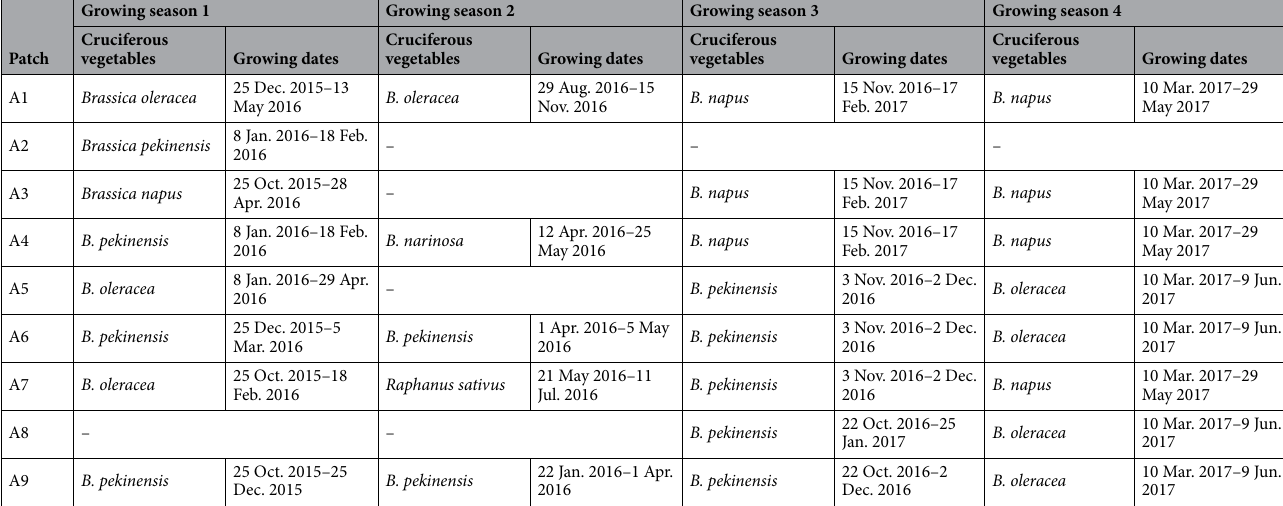
Table 1. Seasonal schedule for growing cruciferous vegetables in different patches of the landscape within the study area, from October 2015 to October 2017. “–” represents non-cruciferous vegetables grown at the corresponding growing dates in the